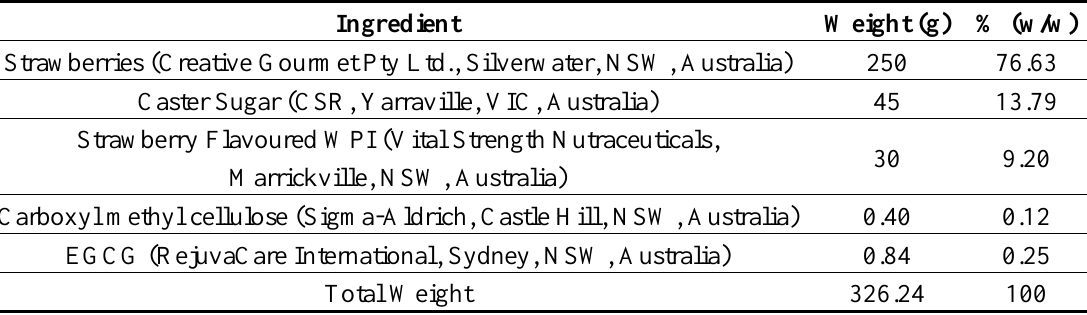
Table 1. Ingredients used in the preparation of the strawberry